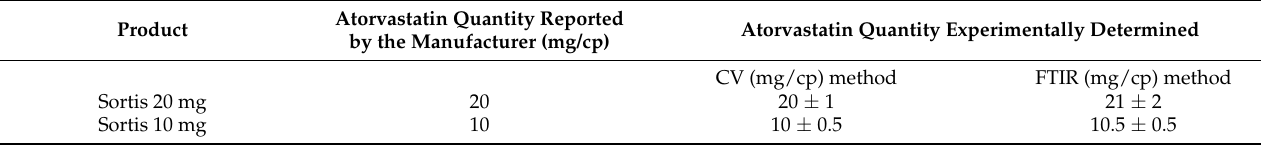
Table 6. Atorvastatin concentrations in Sortis obtained by voltammetry and, respectively, by FTIR.